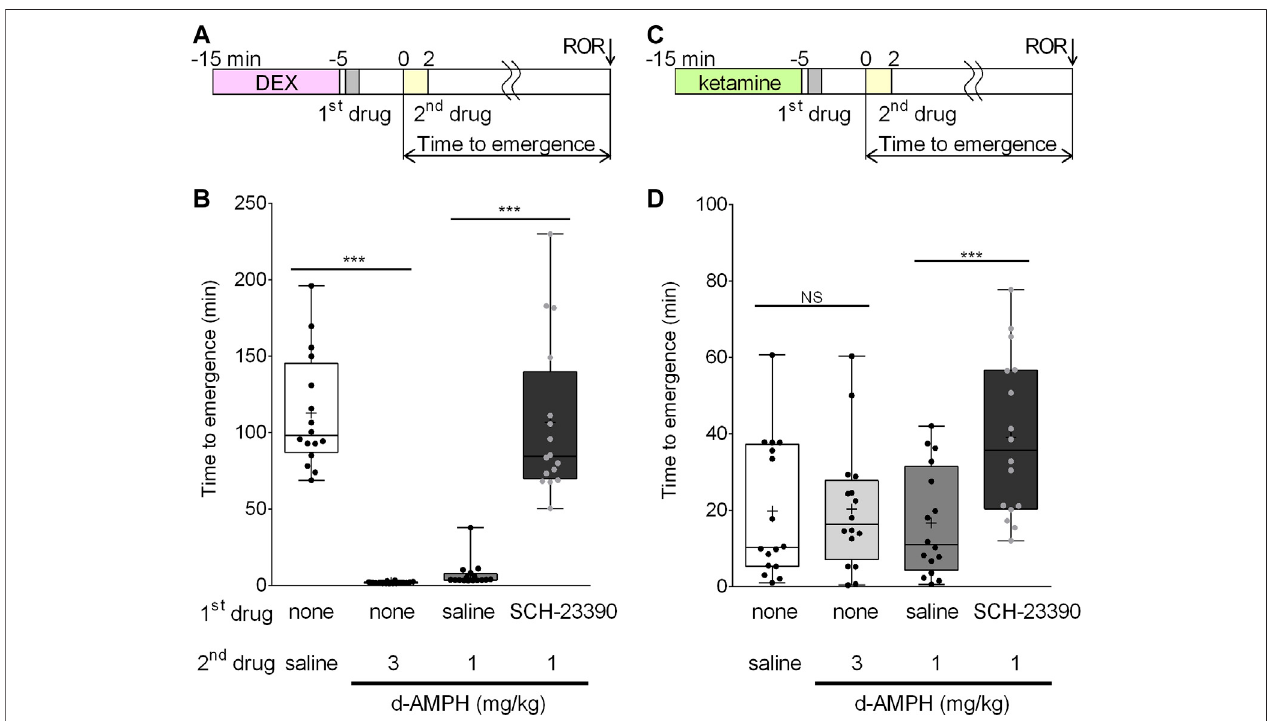
FIGURE 1 | D-amphetamine accelerates recovery from unconsciousness induced by dexmedetomidine, but not ketamine. (A) Time course of the behavioral experiments with dexmedetomidine. The onset of the second drug infusion is set as time (cid:1) 0. (B) Box-whisker plot of the time to emergence in all 16 rats after dexmedetomidine (50 μ g/kg), followed by the listed drugs (plus sign (cid:1) mean time to emergence, fi lled circle (cid:1) individual data point). (C) Time course of the behavioral experiments with ketamine. The onset of the second drug infusion is set as time (cid:1) 0. (D) Box-whisker plot of the time to emergence in all 16 rats after ketamine (50 mg/kg), followed by the listed drugs (*** p < 0.001; Bonferroni post-hoc comparison; N.S. (cid:1) not signi fi cantly different).